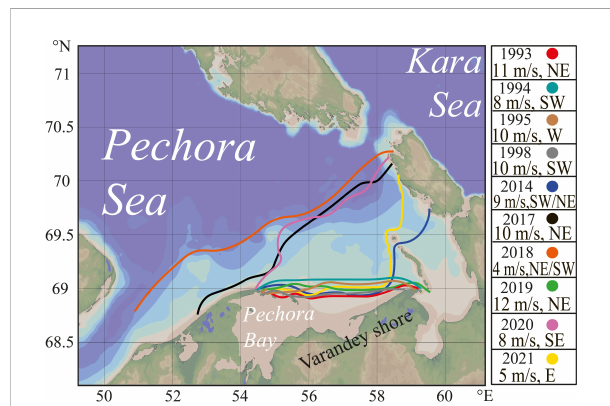
FIGURE 7 Locations of the isohaline of 25 in the surface layer in the Pechora Sea, which represents the Pechora plume border, detected by in situ measurements during fi eld surveys and supported by satellite data. Average wind forcing conditions during the periods of fi eld surveys are shown in the